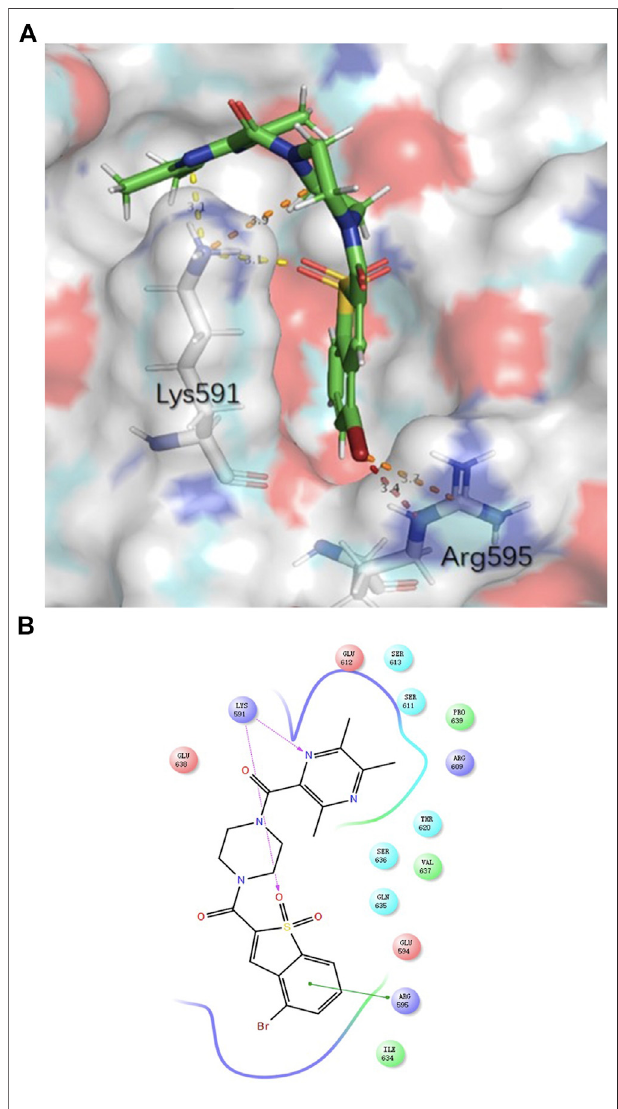
FIGURE 2 | The binding mode of Statmp-151 with Stat3 pocket. (A) Statmp-151 possesses a favourable pose interacting with Stat3 residues. (B) The interaction diagram for Statmp-151 interacting with Stat3